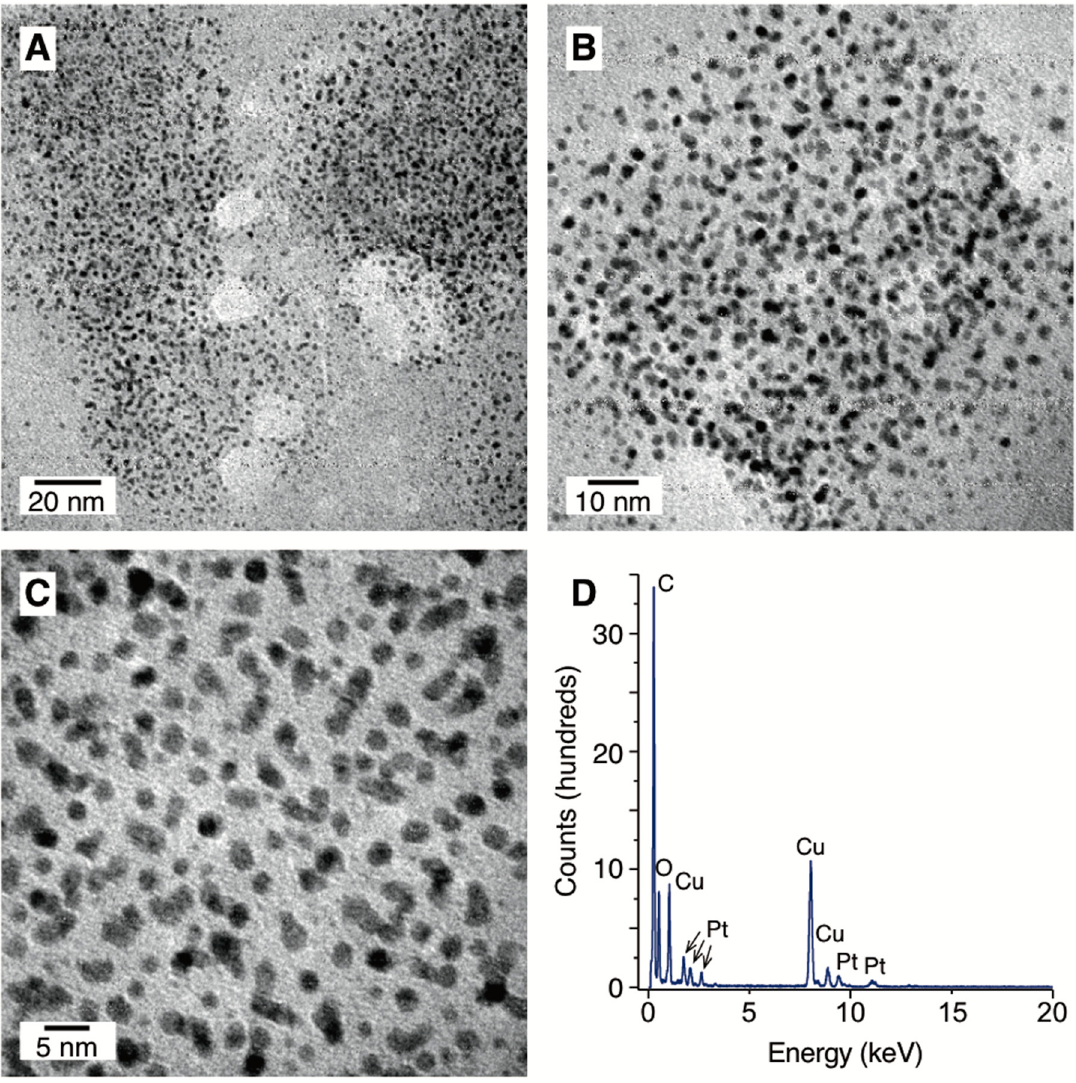
Figure 4. Granulometric properties of PVP ‐ PtNPs synthesized with the aid of dc ‐ APGD. ( A – C ) Representative TEM photomicrographs; ( D ) the EDX spectrum. Representative TEM photomicrographs; ( D ) the EDX